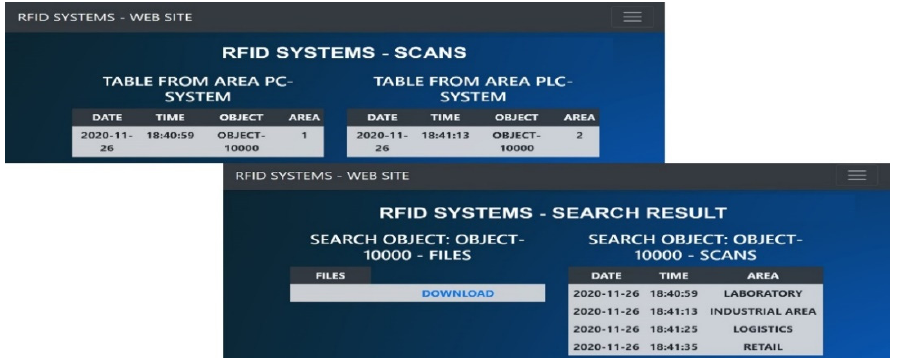
Figure 18. Structure of the developed Web-Platform.